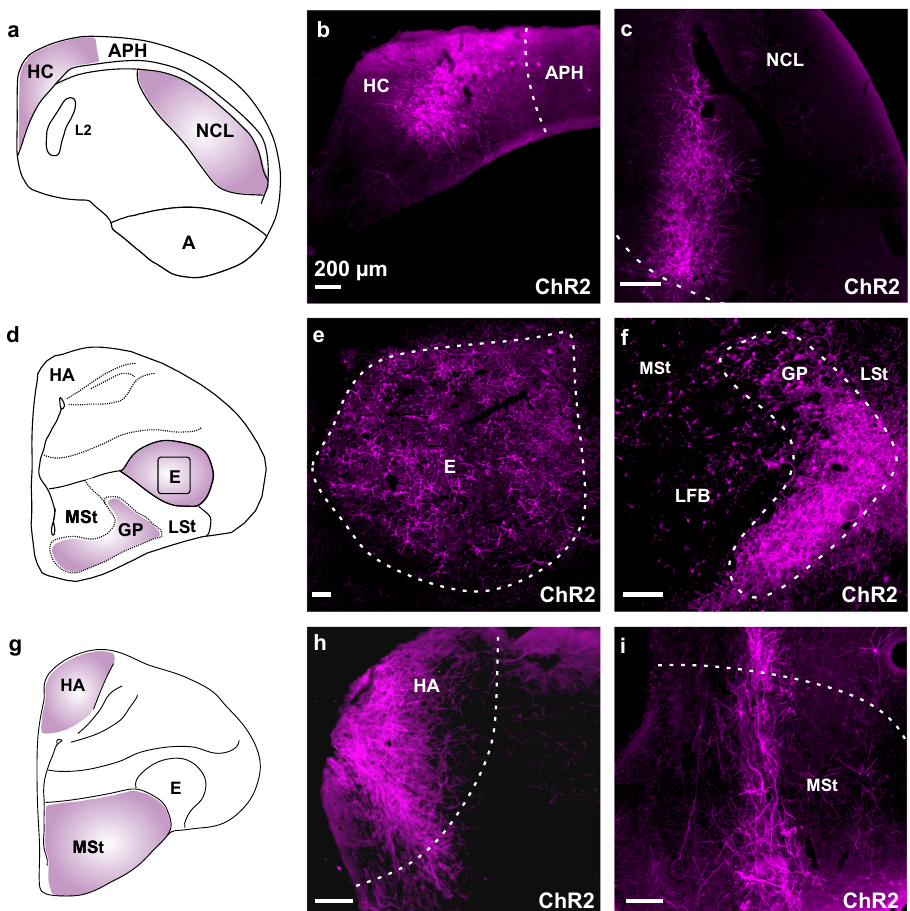
Fig. 3 AAV1-CAG is ef fi cient in driving transgene expression in various regions of the pigeon forebrain. a Schematic illustration of the hippocampus (HC) and nidopallium caudolaterale (NCL). b ChR2 expression in HC. c ChR2 expression in NCL. d Schematic illustration of the entopallium (E) and globus pallidus (GP). e ChR2 expression in E. f ChR2 expression in GP. g Schematic illustration of the hyperpallium apicale (HA) and the medial striatum (MSt). h ChR2 expression in HA. i ChR2 expression in MSt. All scale bars represent 200 µ m. Abbreviations: APH area parahippocampalis, E entopallium, GP globus pallidus, HA hyperpallium apicale, HC hippocampus, LFB lateral forebrain bundle, LSt lateral striatum, MSt medial